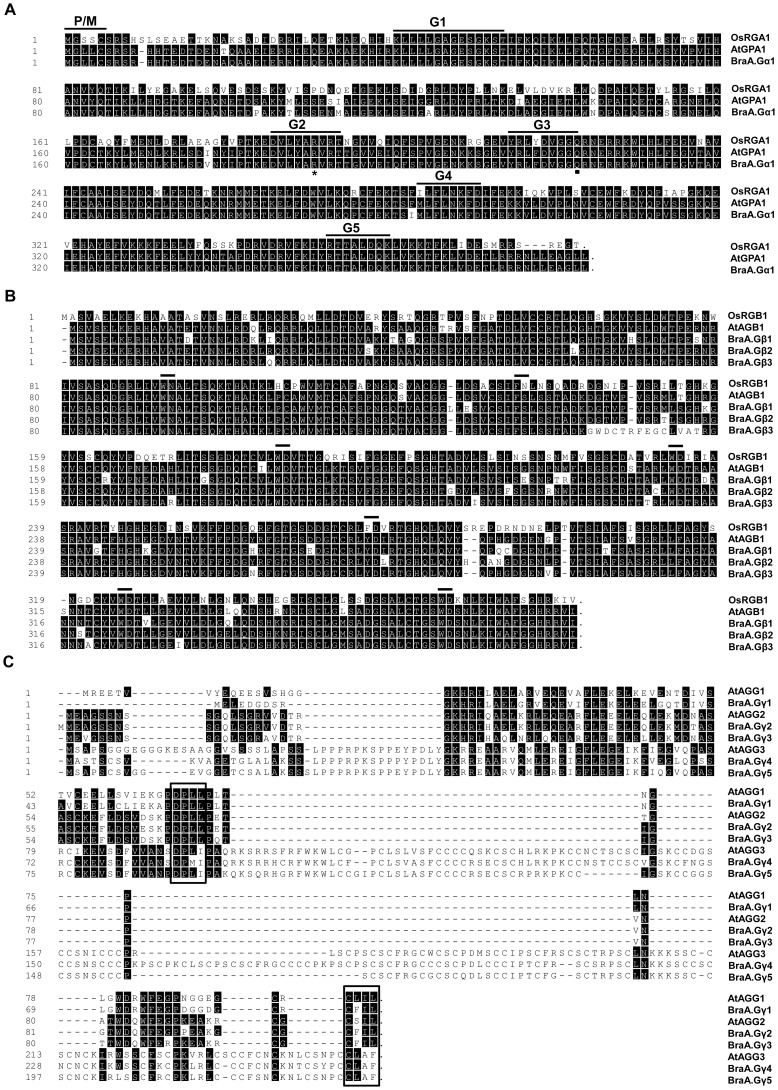
Amino acid sequence alignment of G-protein subunits of B. rapa.(A) The sequence alignment of B. rapa (BraA.Gα1) proteins with Gα protein of rice (OsRGA1) and Arabidopsis (AtGPA1). Consensus sequences for GTP binding and hydrolysis are labeled with G1–G5 boxes. P/M, the predicted site for palmitoylation/myritoylation (MGXXCS); closed square, the conserved glutamine (Q222) important for the GTPase activity of Gα proteins; *, the conserved ADP ribosylation site in Gα proteins. (B) Amino acid sequence alignment B. rapa (BraA.Gβ1-3) proteins with Gβ proteins of rice (OsRGB1) and Arabidopsis (AtAGB1) and. Seven WD repeats are marked with horizontal bar. (C) Amino acid sequence alignment of B. rapa (BraGγ1-5) proteins with Arabidopsis (AtAGG1-3) proteins. Conserved DPLL motif (provides hydrophobic contact to Gβ subunit proteins), and CaaX domain (required for attachment to cell-membrane) are marked within boxes, in order. The amino-acid sequence alignment of G-protein subunits was performed using ClustalW. The conserved and divergent residues are shaded in dark and white backgrounds, respectively.